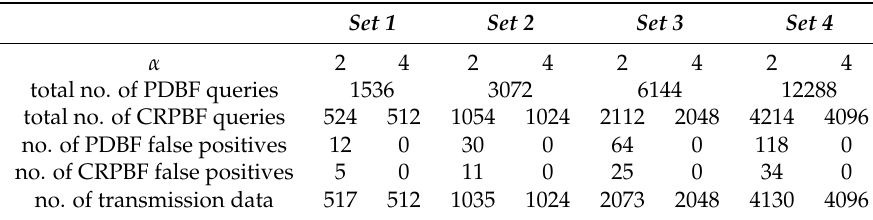
Table 2. Bloom filter